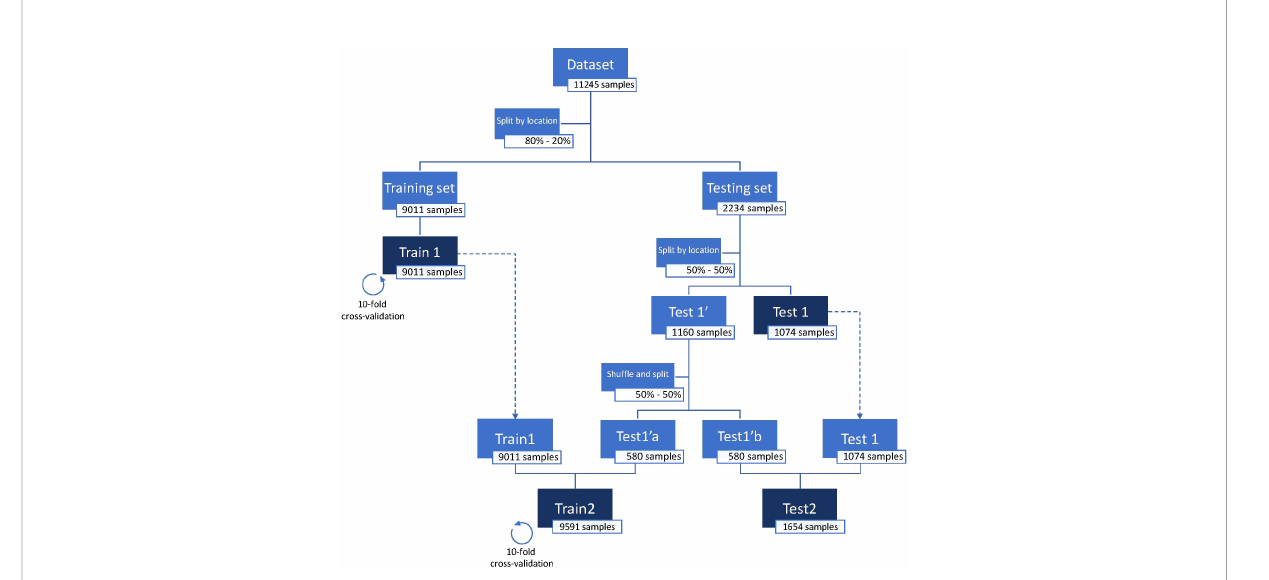
FIGURE 2 Diagram of the strategy to obtain the training and testing sets to test over- fi tting and data